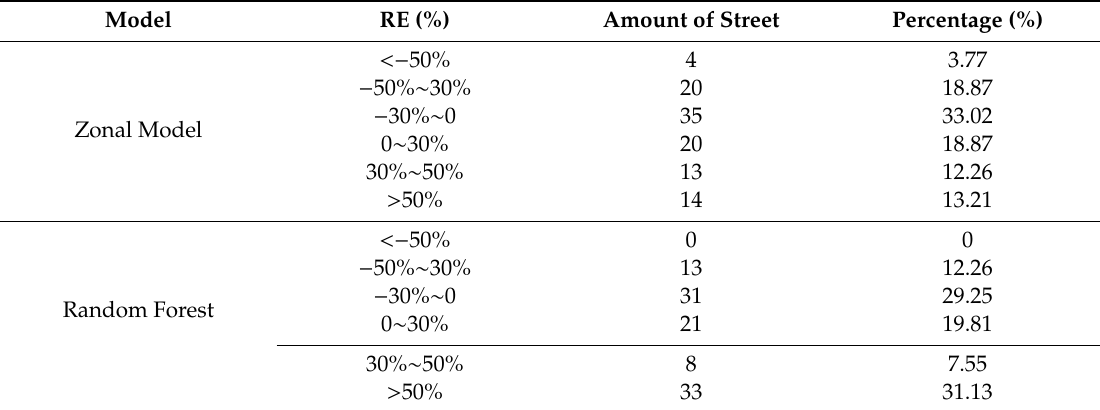
Table 8. Error statistics for models in the whole area.